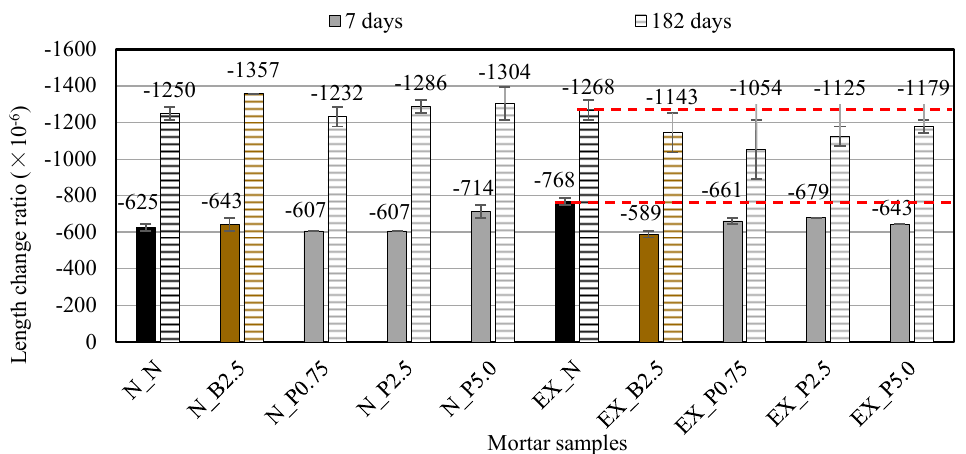
Figure 7. Length-change ratio in the dry environment for ordinary and expansive mortars. (black: without NFBC, brown: with NFBC type B f , grey: with NFBC type P f )